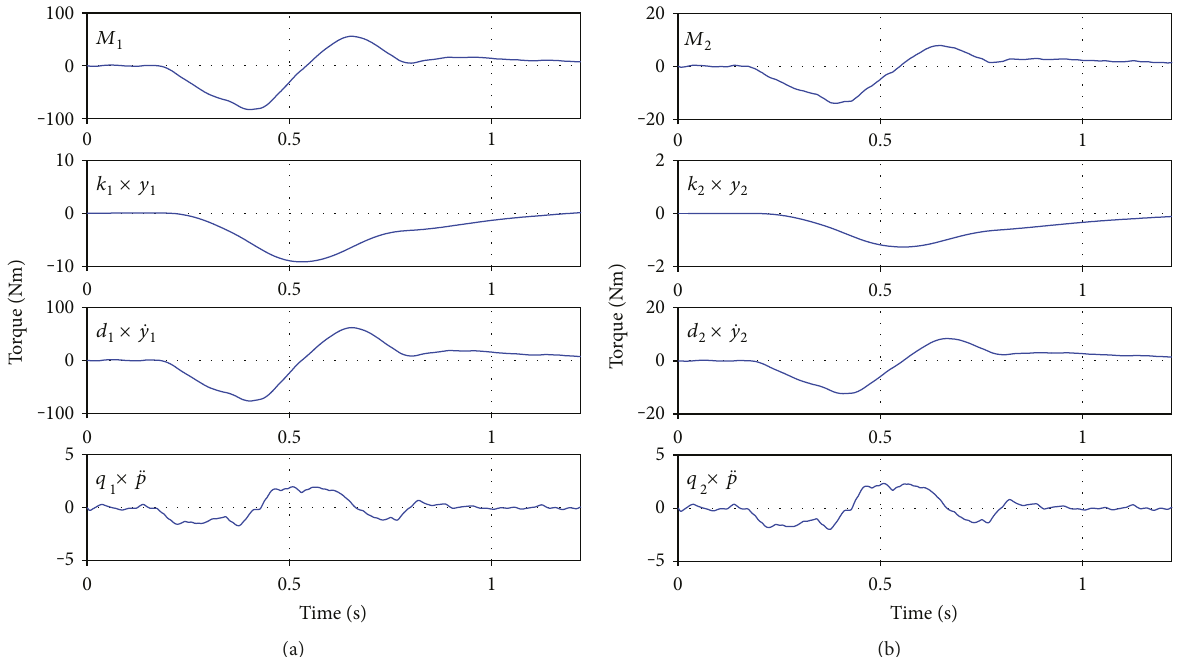
Figure 12: Controller IIIc in the test trial ((5)14200lt). (a) M avrg and split into components. As can be easily seen, the primary in fl uence on the applied torques always stems from the velocity contributions, while the other two contributions (displacement and perturbation acceleration) just slightly alter the fi nal